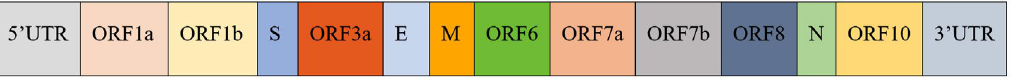
Fig. 3. Genes encoding structural and non-structural proteins make up the Novel Coronavirus Genome. Nucleocapsid (N), spike (S), membrane (M), and envelope (E) proteins are structural proteins. Each box represents a gene.